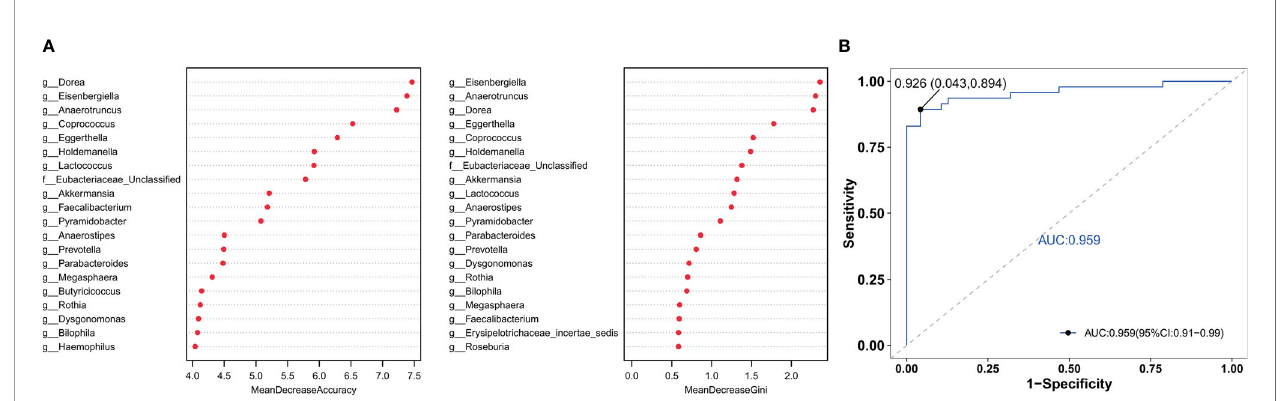
FIGURE 4 | The RF model was used to build a predictive model of genus-level abundance taxa (A) . The relative importance of each genus in the predictive model was evaluated using the mean decreasing accuracy and the Gini coef fi cient. (B) Receiver operating characteristic curve (ROC) generated using 20 genera in the